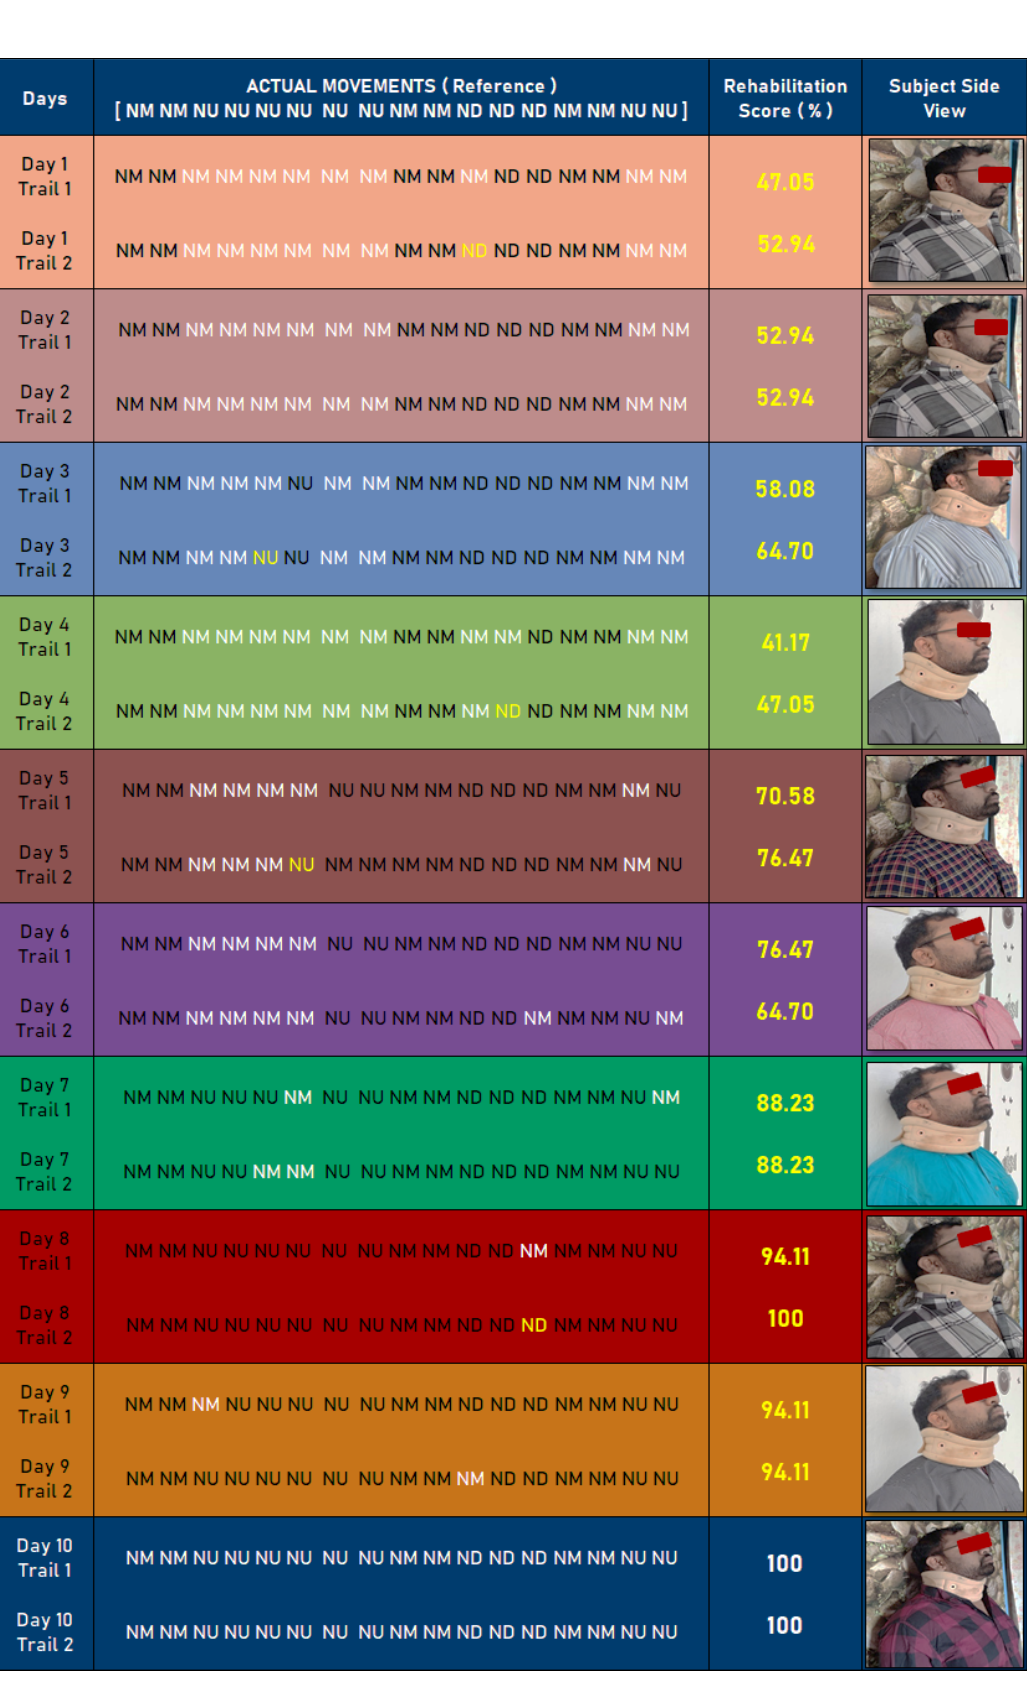
Figure 12. Synthetic dataset-based analysis of rehabilitation system.